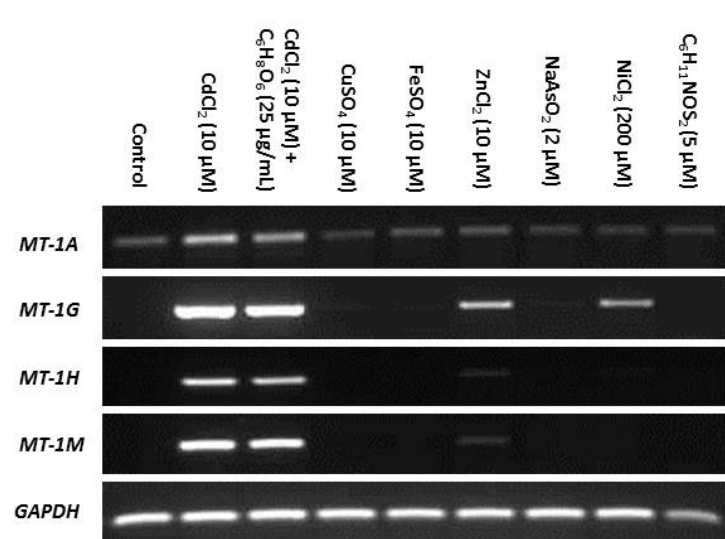
Figure 3. Specificity of metallothionein (MT) transcription induction by cadmium. MT gene